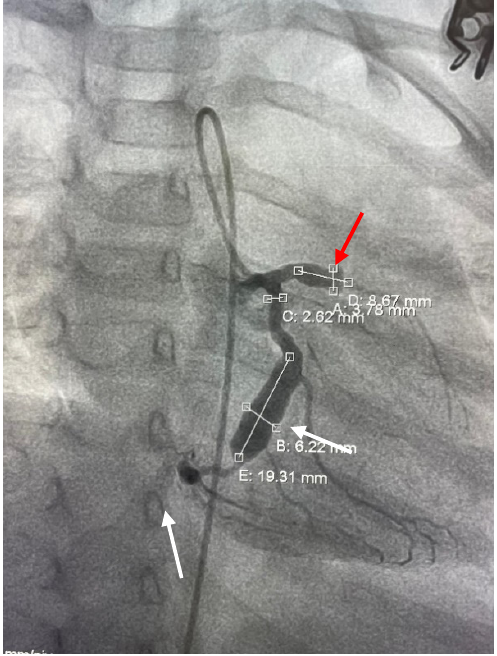
Figure 5. Coronary angiography. Multiple coronary aneurysms on the anterior descending artery (stop flow, thrombosis process in progress: red arrow) and on the circumflex artery (white arrows).